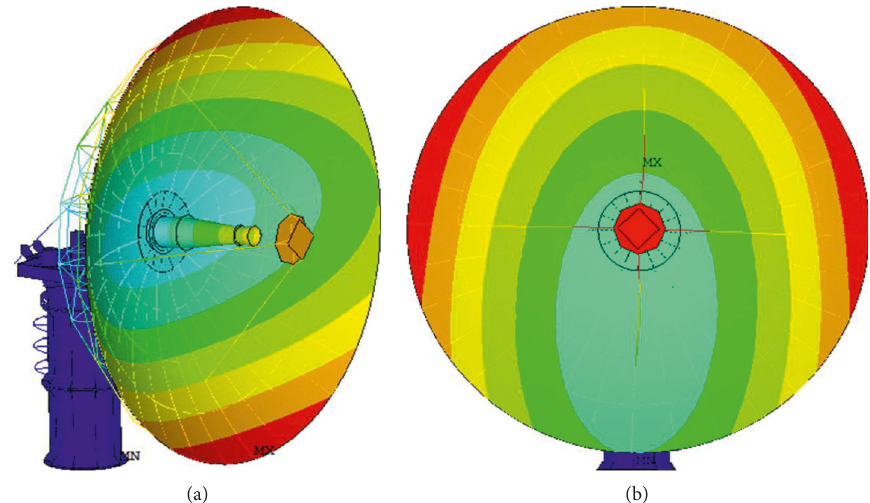
Figure 6: The first two modes of the antenna in the (a) elevation direction and (b) azimuth